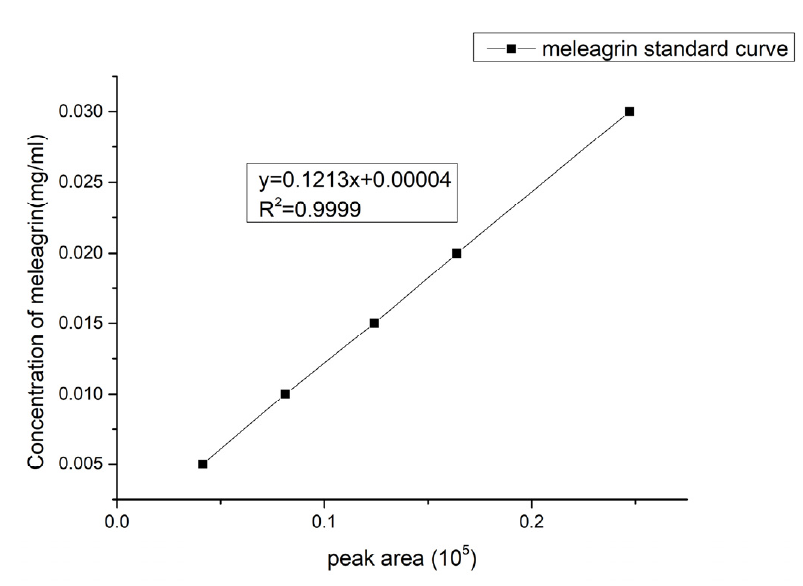
Figure 6. Meleagrin standard curve.